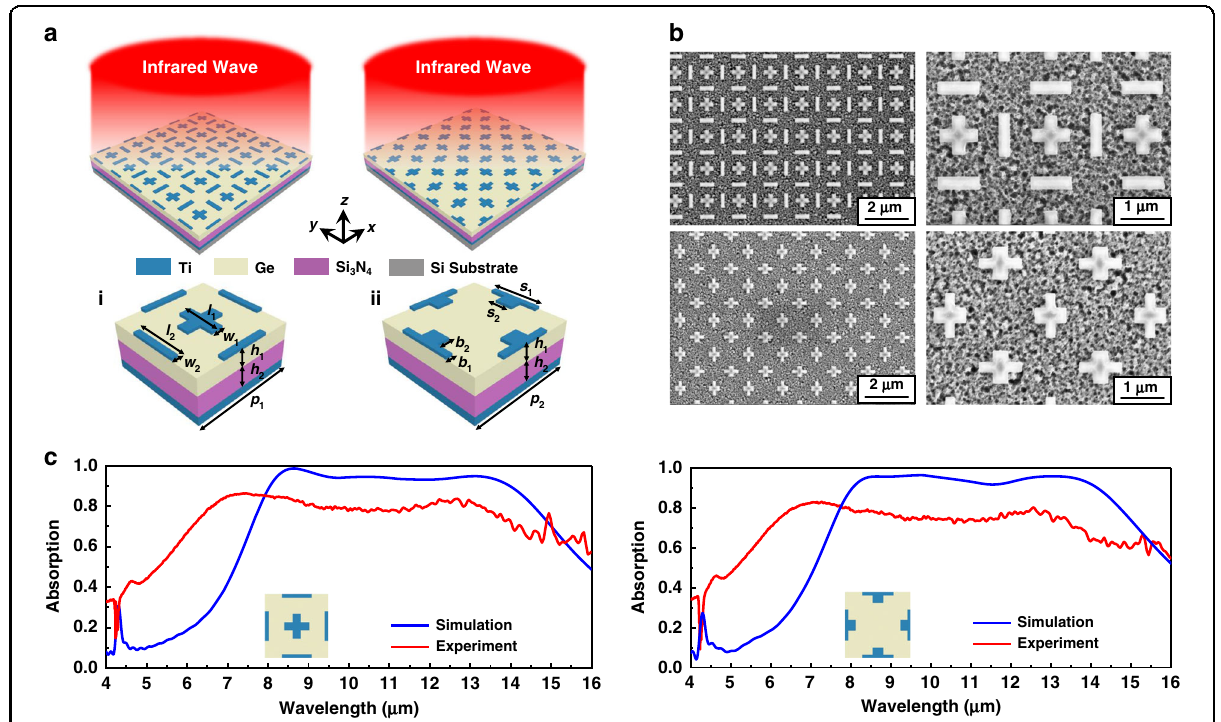
Fig. 3 Absorption characteristics of two types of Ti/Ge/Si 3 N 4 /Ti absorbers. a Schematic of two types of Ti/Ge/Si 3 N 4 /Ti absorbers ( h 1 = 270 nm, h 2 = 330 nm, p 1 = 1.6 μ m and p 2 = 1.8 μ m): (i) the top layer consists of periodic nano-cross and nano-strip structures ( l 1 = 630 nm, w 1 = 200 nm, l 2 = 750 nm and w 2 = 100 nm); (ii) the top layer consists of irregular nano-cross structures ( s 1 = 850 nm, b 1 = 100 nm, s 2 = 300 nm and b 2 = 200 nm). The thickness of the top Ti layer is 22 nm, and the bottom Ti layer is 120 nm, where is thicker than its penetration depth. b SEM images of two types of fabricated Ti/Ge/Si 3 N 4 /Ti absorbers. c Simulated and experiment absorption spectra of the two types of Ti/Ge/Si 3 N 4 /Ti